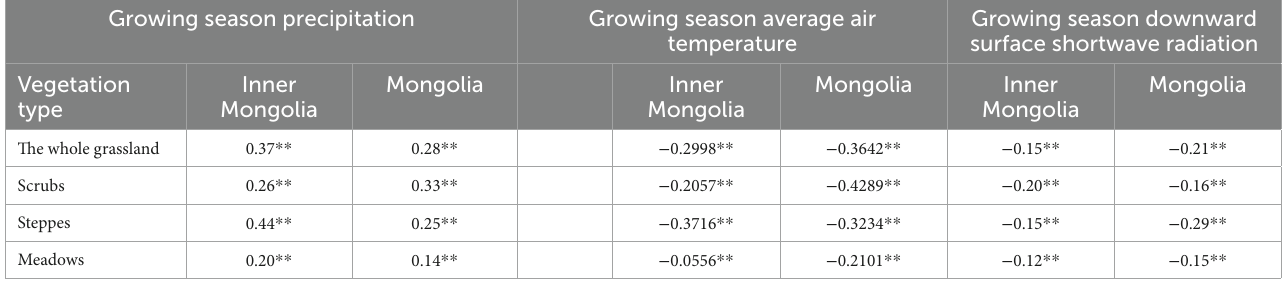
TABLE 5 Partial correlation comparison between NDVI and meteorological factors in growing seasons of Inner Mongolia and Mongolia from 2000 to 2018. Growing season